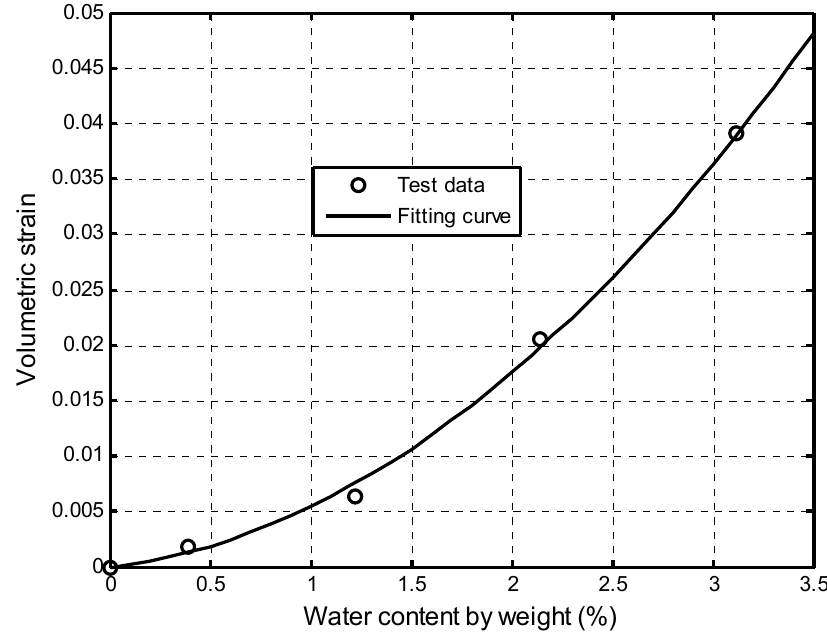
Figure 4. Hydration-induced strain in Mancos shale [42].